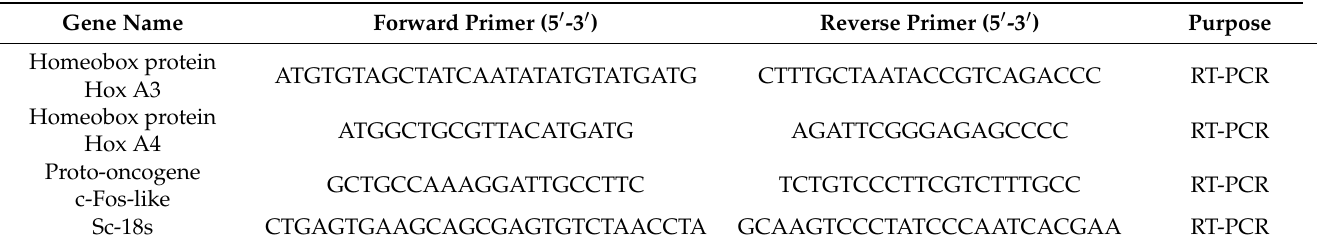
Table 1. Primer sequences used in the